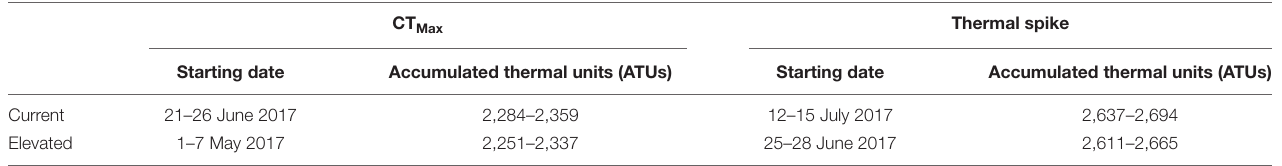
TABLE 1 | Starting dates for the CT Max and thermal spike experiments in Chinook salmon ( Oncorhynchus tshawytscha ) with the respective accumulated thermal units (ATUs). CT Max Thermal spike Starting date Accumulated thermal units (ATUs) Starting date Accumulated thermal units